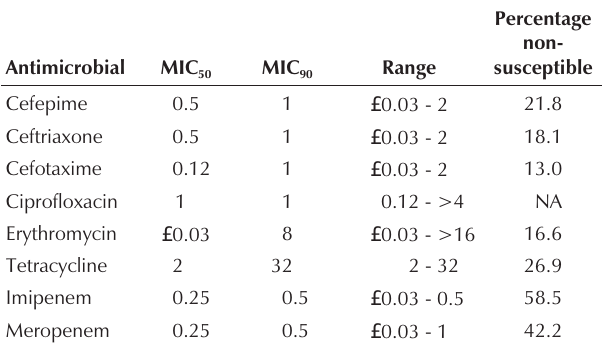
Results of susceptibility testing for selected antimicrobials against 193 penicillin-nonsusceptible Streptococcus pneumoniae , expressed as minimum inhibitory concentration (MIC) 50 and MIC 90 (mg/L), range (mg/L)